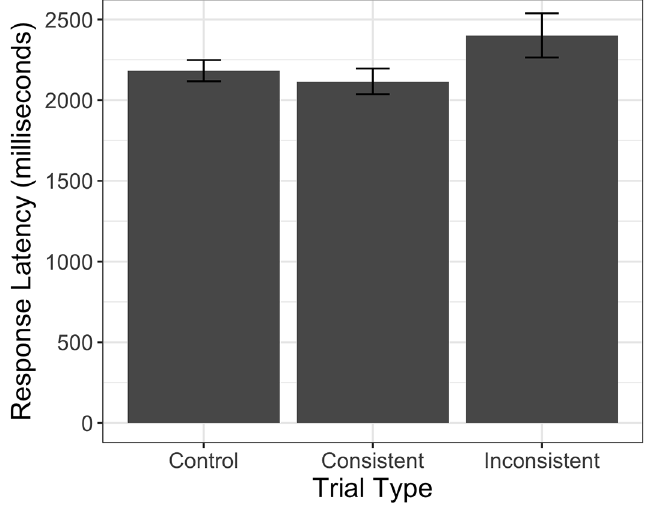
Figure 3. Effect of trial type on response latency in Experiment